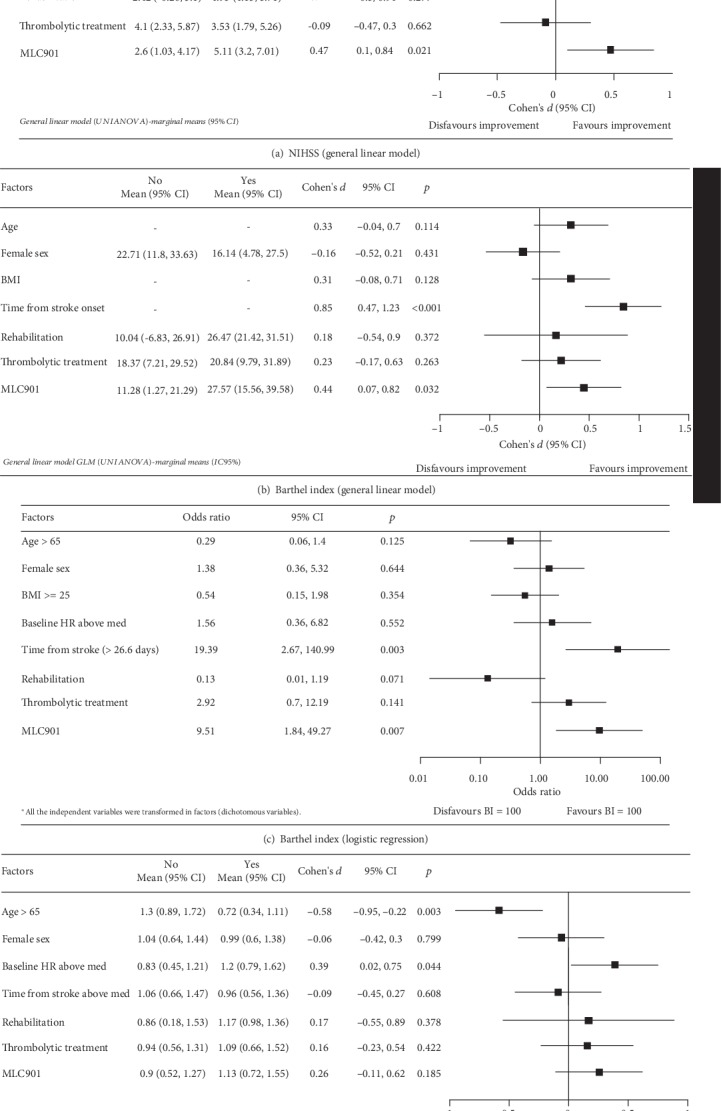
Multivariable analysis of factors influencing improvements on NIHSS (a), Barthel index (b, c), and mRS (d) at month 3.